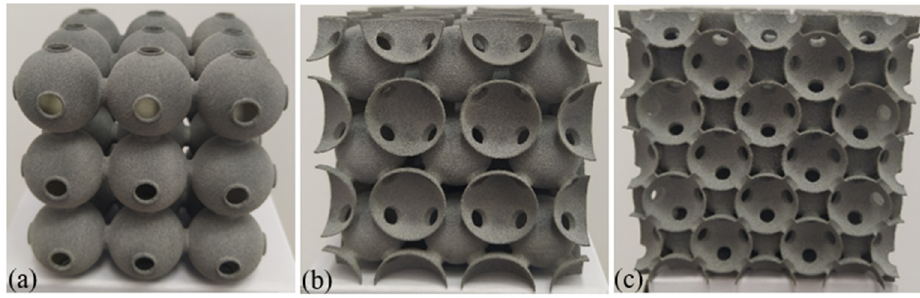
Figure 2. A 3D printed PHSS: ( a ) SC; ( b ) BCC; ( c ) FCC.